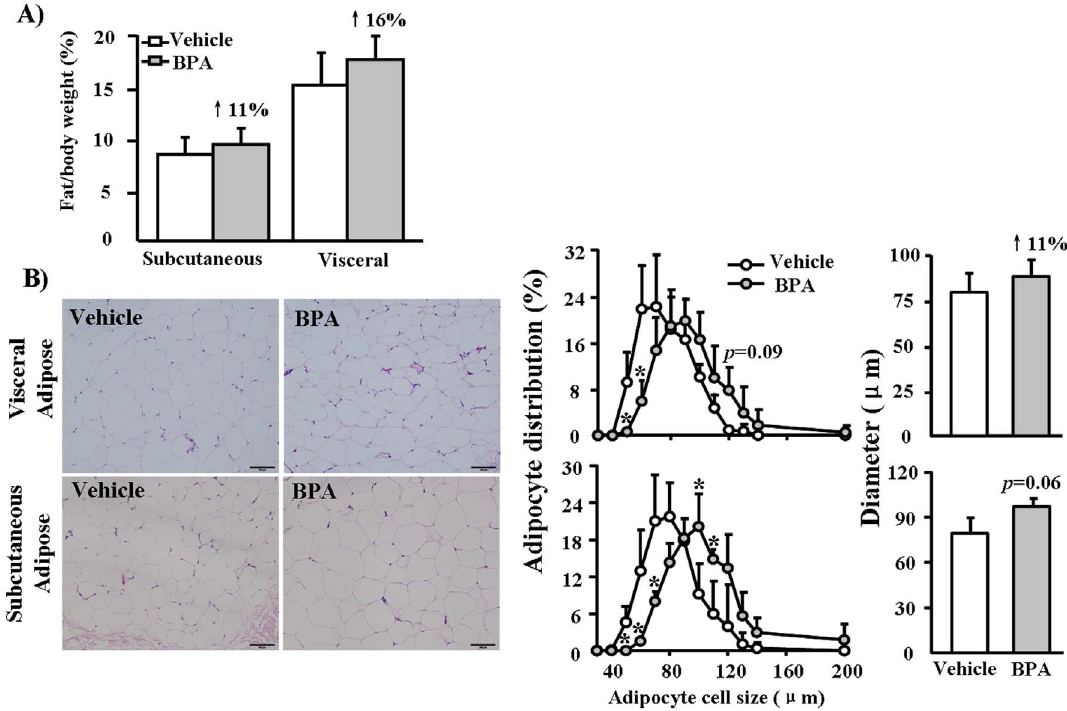
Figure 8. Pathological analysis of adipose in WHHL rabbits at 12 weeks. (A) The total mass of adipose tissue was measured and expressed as the ratio of adipose tissue weight to body weight. (B) Representative micrographs of adipose tissue (H&E-stained specimens), morphometric analysis of adipocyte cell size distribution and mean diameters in the vehicle and BPA-exposure. (400 m g/kg) groups. Data are expressed as the means 6 SD, n=6 for each group. * p , 0.05 vs. vehicles.